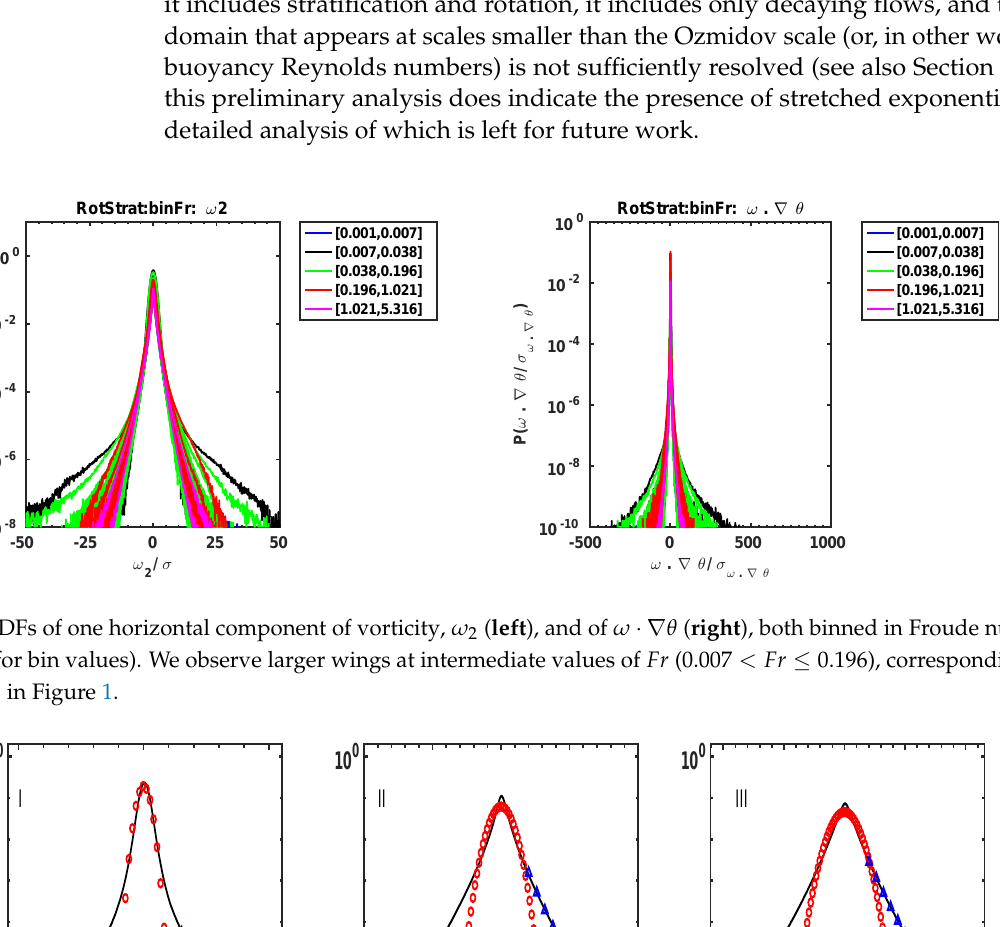
Figure 3. Probability Density Functions of the ω 2 (horizontal) component of vorticity, in lin-log coordinates, for runs rI ( left ), rII ( middle ) and rIII ( right ), in the three regimes of rotating stratified turbulence. The S , B and C parameters refer to a ) ; the fit domain is given by blue triangles, and the red circles stretched exponential fit in the tails, P ( ω 2 ) = B exp ( C ω S 2 − correspond to Gaussian profiles computed from the distribution mean and standard